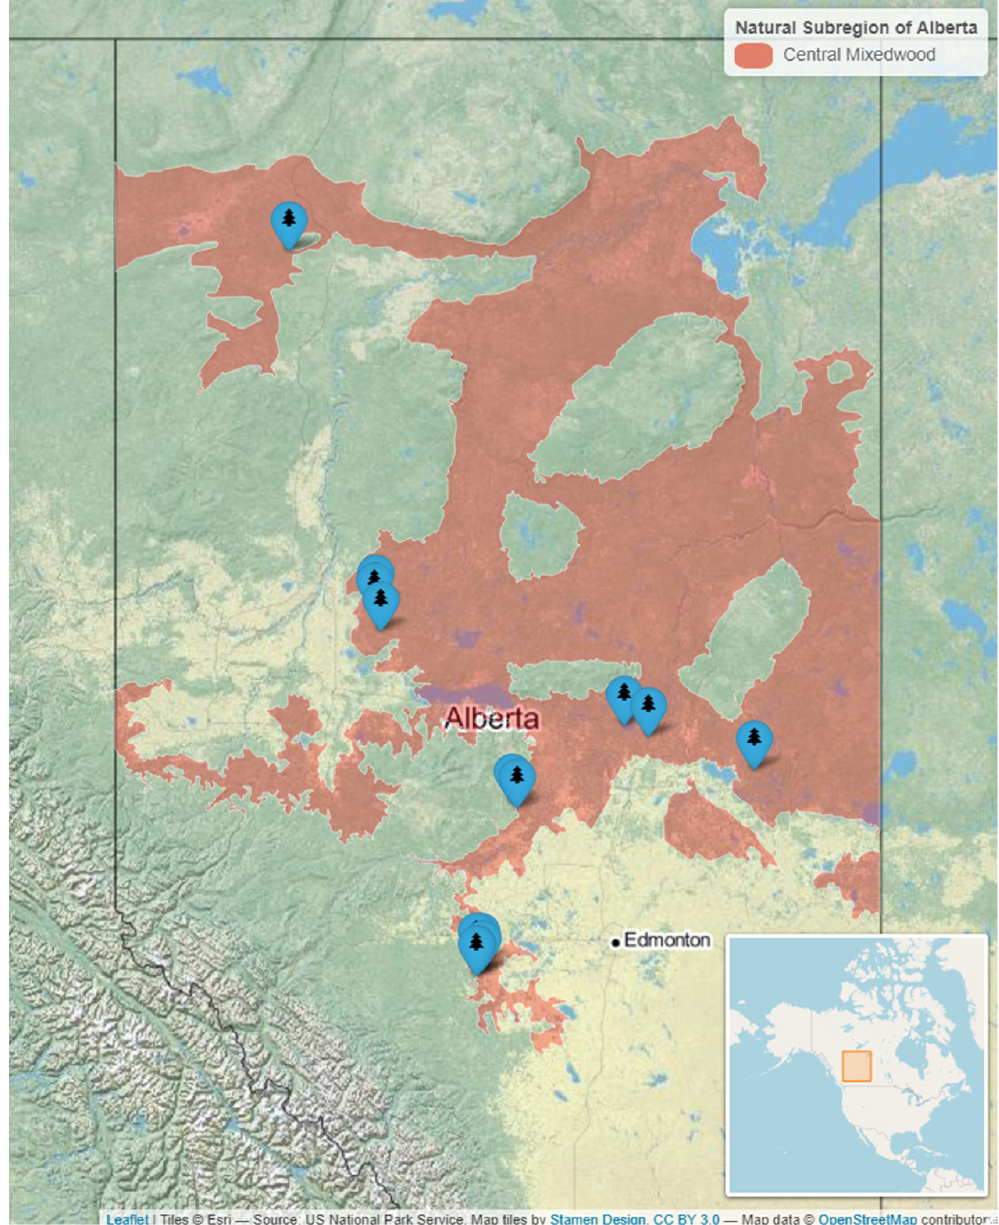
Figure 1. Locations of the 14 Dynamic Aspen Density Experiment (DADE) installations across the Central Mixedwood Natural Subregion in Alberta, Canada.